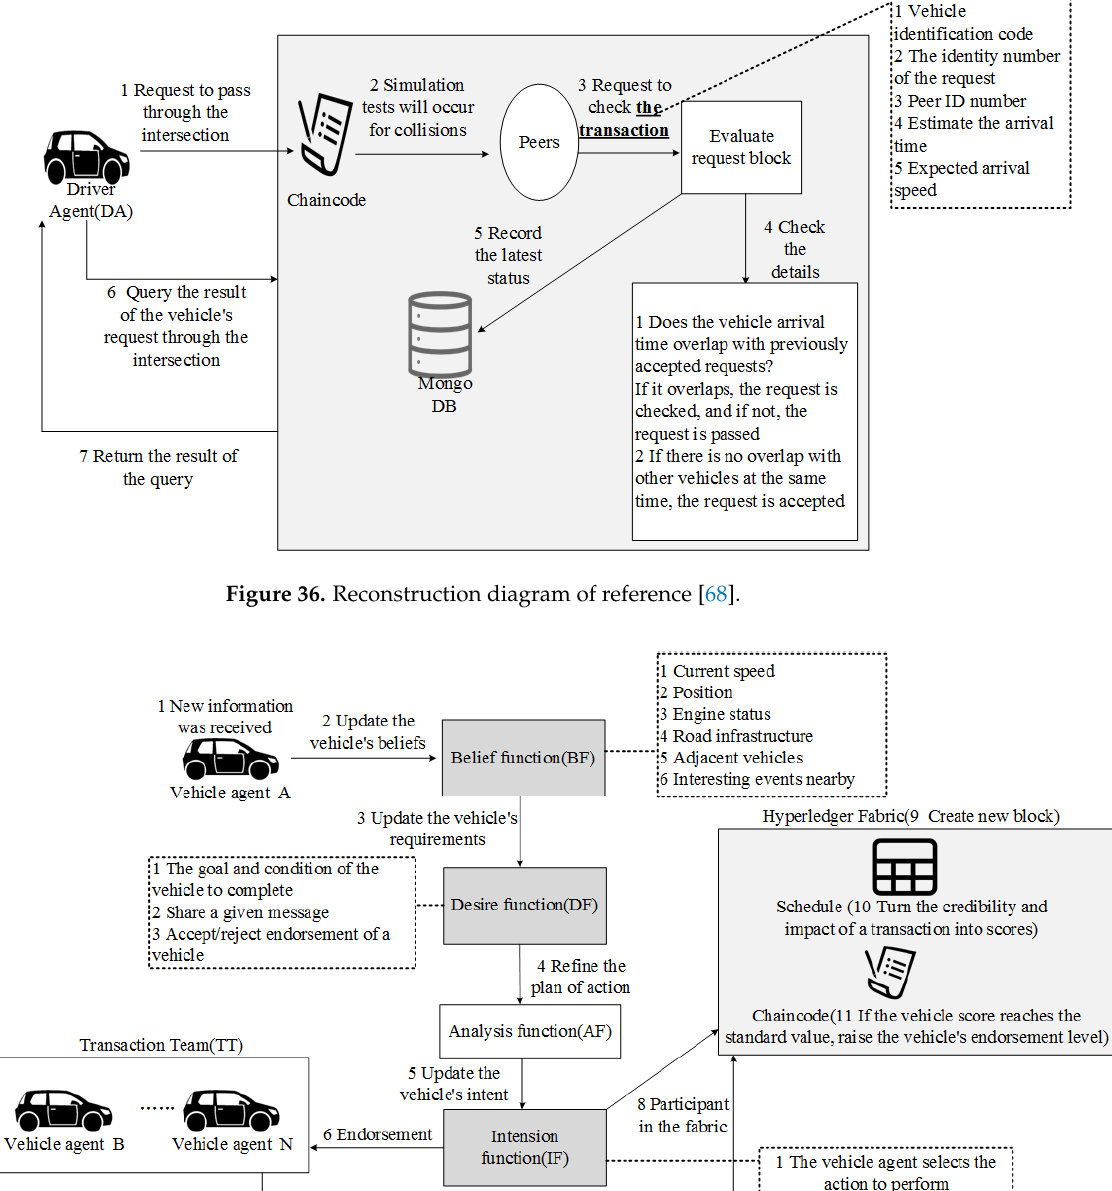
Figure 38. Reconstruction diagram of reference [70].